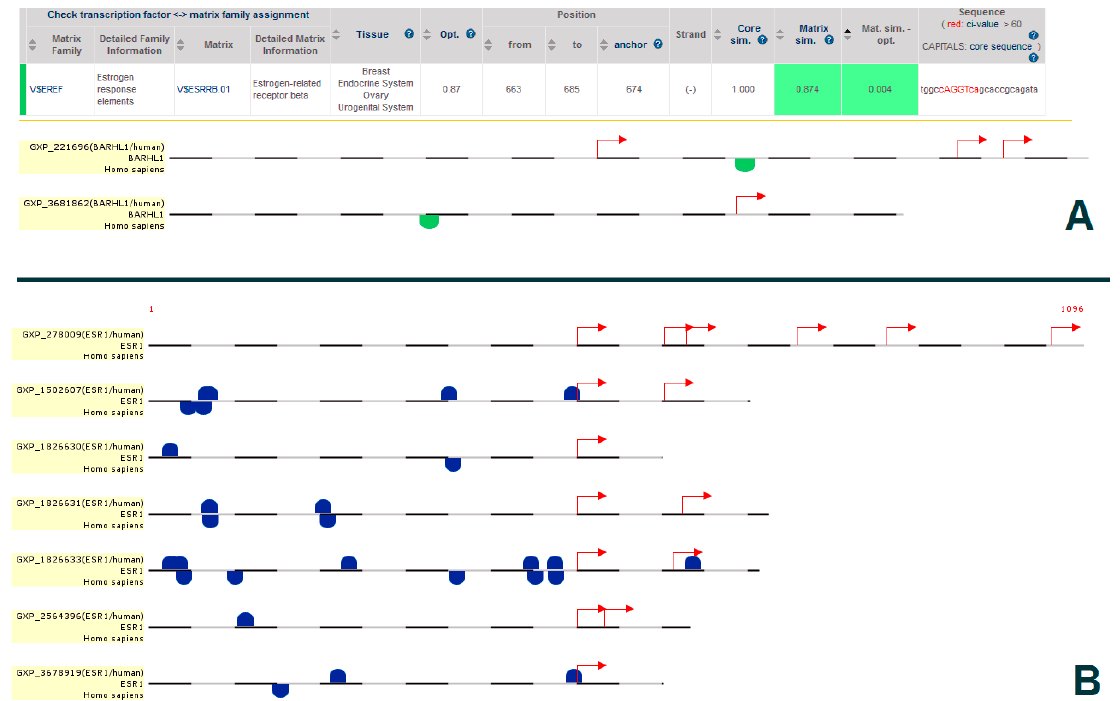
Figure 4. ( A ) ESR1 binding sites in the BARHL1 promoter and ( B ) BARHL1 binding sites in the ESR1 promoter. The green dots show V$EREF matrix family binding sites at BARHL1 promoter and blue dots indicate the V$HOMF matrix family binding sites at ESR1 promoter. The red arrows indicate the transcription start sites.